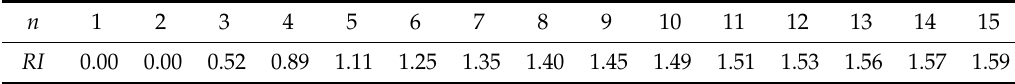
Table 2. The value of the random consistency index ( RI )